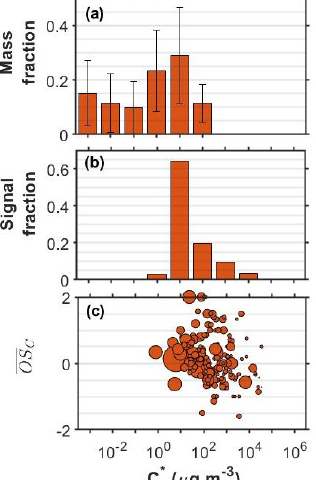
Figure 1. SOA particle volatility distributions from (a) the TD mea- surements ( ± retrieval uncertainty) and (b) the FIGAERO-CIMS measurements in the α -pinene experiments conducted at half and one-third initial reactivity. (c) All the products identified by the FIGAERO-CIMS are shown as a function of their volatility ( C ∗ ) and their average carbon oxidation state (OSc) sized by the square root of their particle-phase signal.